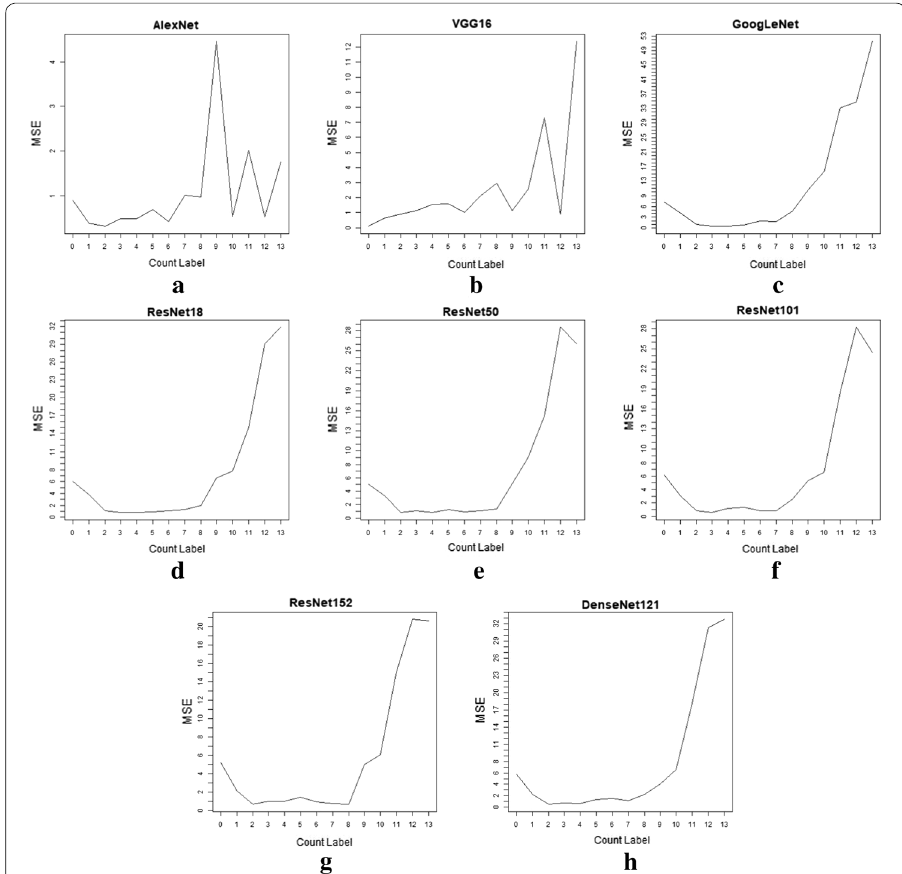
Fig. 4 MSE versus count label plots for all models: a AlexNet, b VGG16, c GoogLeNet, d ResNet18, e ResNet50, f ResNet101, g ResNet152, h